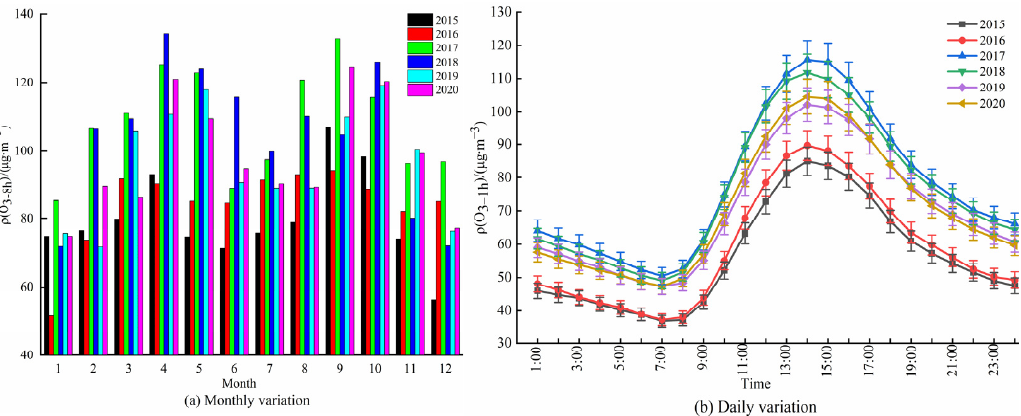
Figure 2. Monthly ( a ) and hourly ( b ) concentrations of surface O 3 in PT from 2015 to 2020.